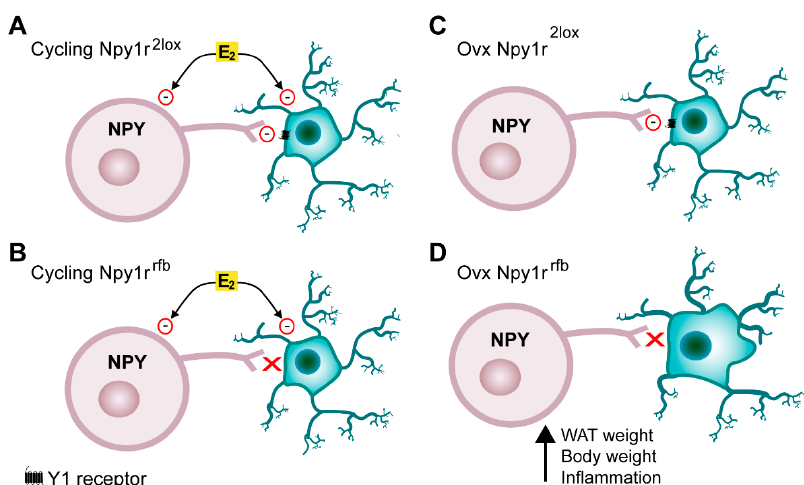
Figure 6. Interactions between estradiol and the NPY-Y1 receptor system in the ARC. ( A ) Estrogens (E2) directly inhibit NPY neurons. Microglia activation and proliferation is increased by HFD and inhibited by E2 and the NPY-Y1 receptor system. ( B ) In cycling females, the HFD-induced microglia activation is inhibited by E2 also in the absence of Y1 receptors on microglia. ( C ) In ovx Npy1r 2lox females, NPY inhibits microglia through activation of Y1 receptors. ( D ) In Npy1r rfb ovx females, on both SD and HFD regimen, the deletion of Y1 receptors in microglia increases microglia activation and, in turn, body and WAT weight.